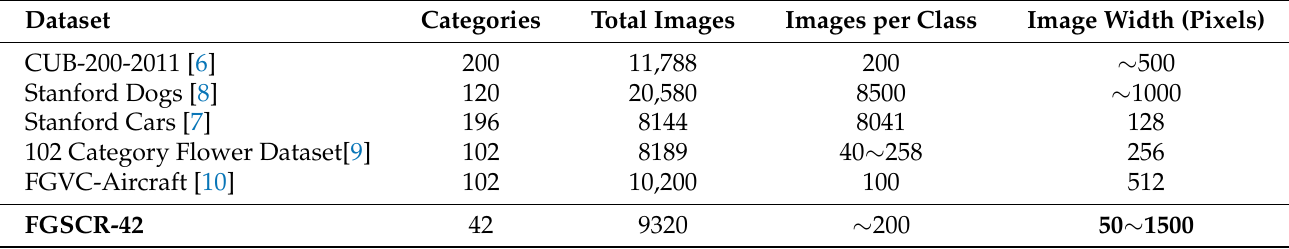
Table 1. Comparison among FGSCR-42 and recent popular natural image datasets.